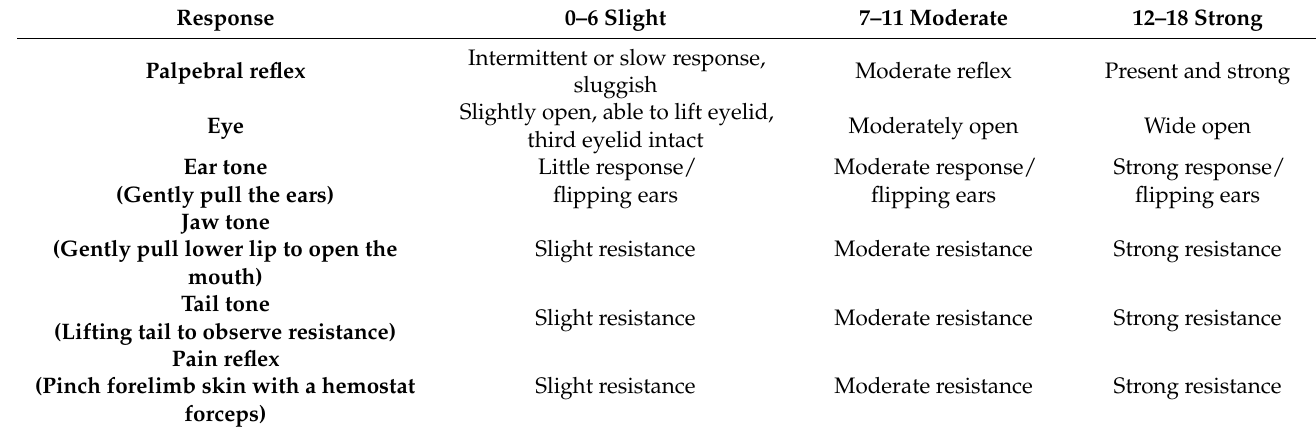
Table 3. Responsiveness score assessment (modified from Nishimura et al., 2018